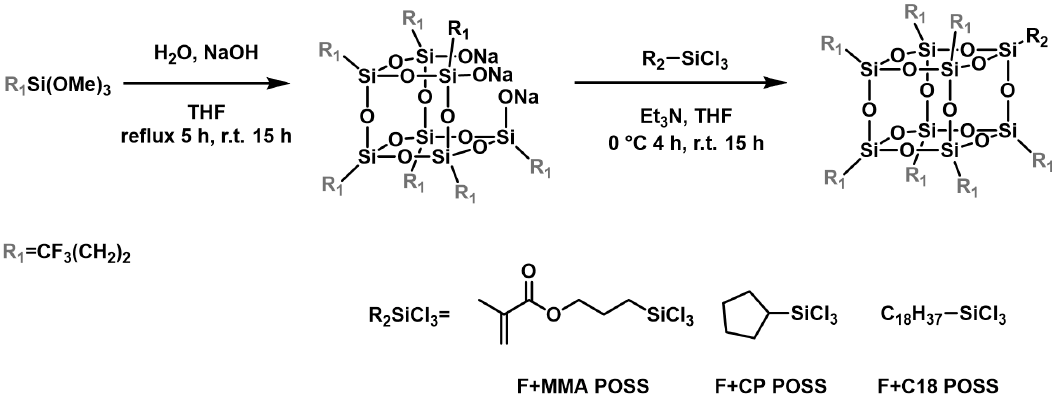
Scheme 1. Synthesis of the polyhedral oligomeric silsesquioxane (POSS) fillers that had a dual type of substituents.